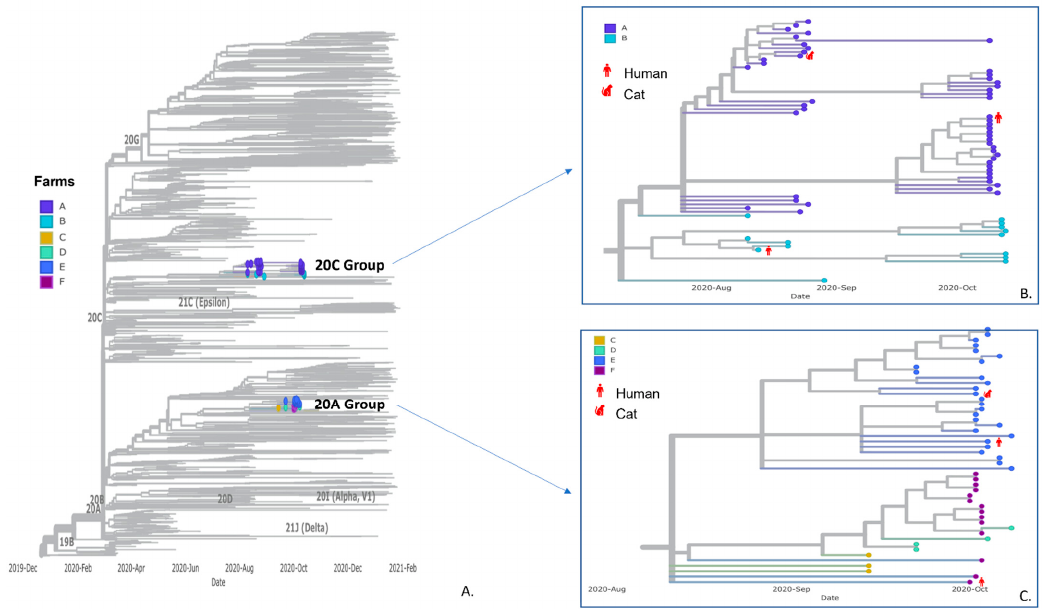
Figure 3. Panel ( A ) SARS-CoV-2 phylogenetic tree including 2250 randomly sampled sequences from human specimens in Utah and sequences from this study. Farm sequences fell onto two branches with zoom-in view of clades 20C group (Panel ( B ); Farms A and B) and 20A group (Panel ( C ); Farms C–F). Sequences are color-coded by farms of origin, and sequences from non-mink hosts are labeled in red with host species. Table 4. Phylogenetic analysis of sequences derived from human and animal specimens from six mink farms in Utah.